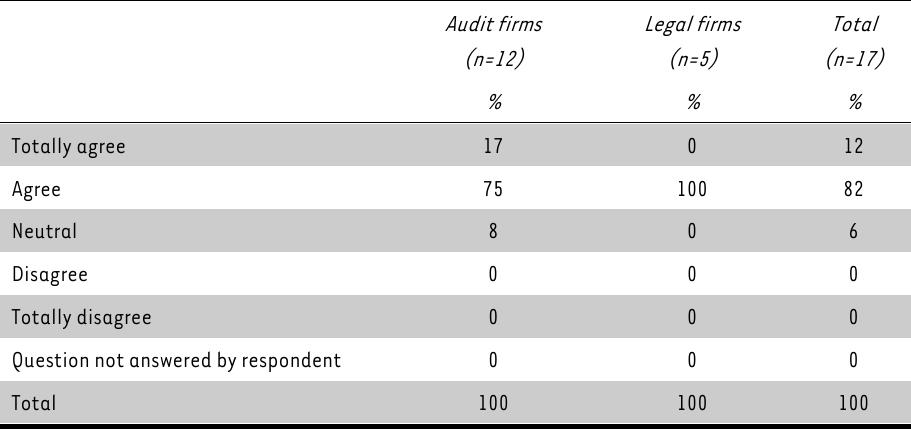
Results of Question